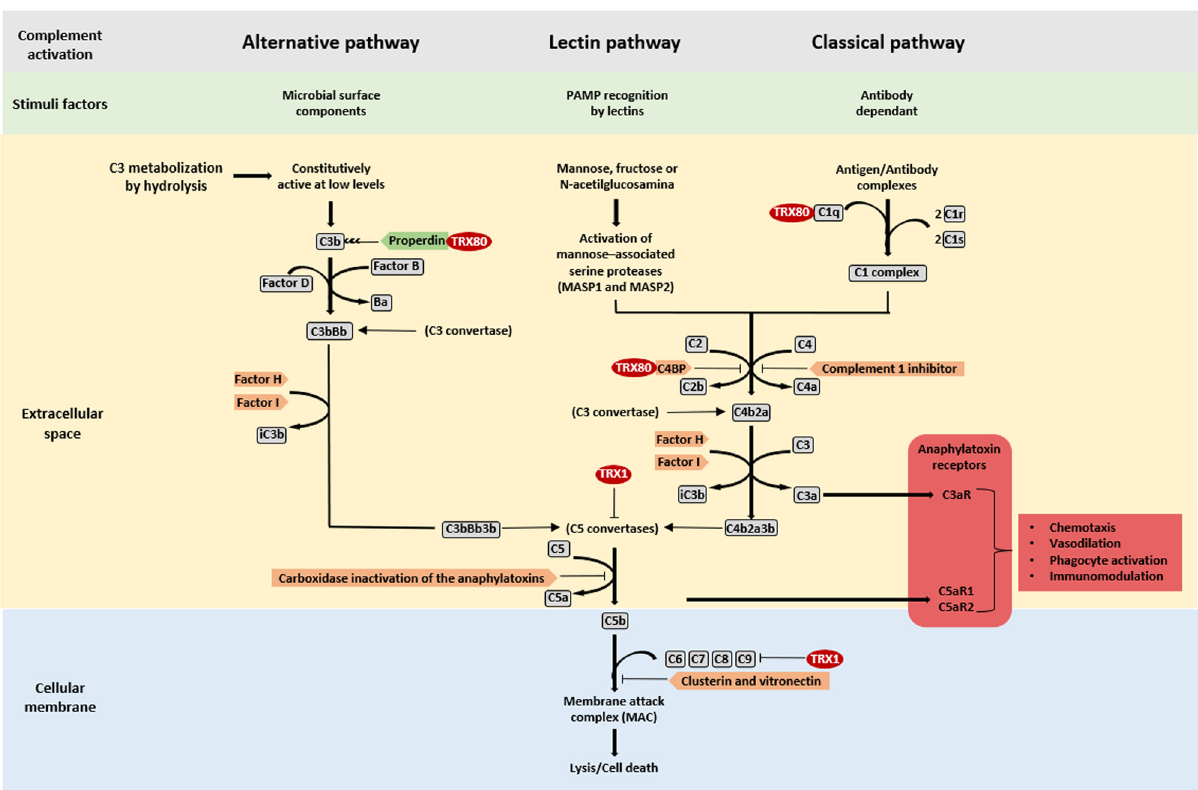
Figure 4: TRX1 and thioredoxin 80 ( TRX80 ) e ff ects on the complement system and proin fl ammatory polypeptides production. TRX1, by interfering at the level of the C5 convertase and C9, inhibits the activation of the complement system, avoiding the formation of the MAC. In contrast, TRX80 acts as an activator of both the classical and the alternative pathways. In the classical pathway, TRX80 promotes the formation of complex C1 through activation of C1q; likewise, the binding of TRX80 to the C4 - binding protein ( C4BP ) interferes with its inhibiting e ff ect. In the alternative pathway, TRX80 binds to properdin, increasing its activity ( sole positive modulator of the complement system ) . Aside from modulating the complement activation, TRX1 and TRX80 exert important e ff ects on the in fl ammatory process by modifying the production of two important anaphylatoxins ( C5a and C3a ) , which, through signaling with their respective receptors ( C5aR and C3aR ) , become involved in processes like chemotaxis and activation of cell groups, such as granulocytes, mastocytes, and